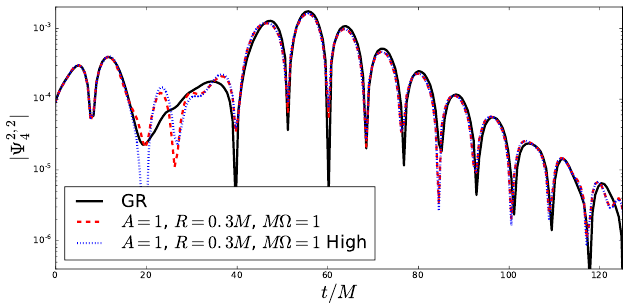
Figure 1 . Signals from a head-on collision for two resolutions. Although not fully converged be- cause there is no continuum solution, the high- and low-resolution results are very similar, suggesting the scheme is reasonably